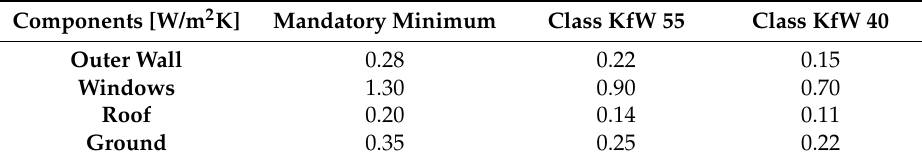
Table 3. Thermal transmittances of components of set efficiency classes.